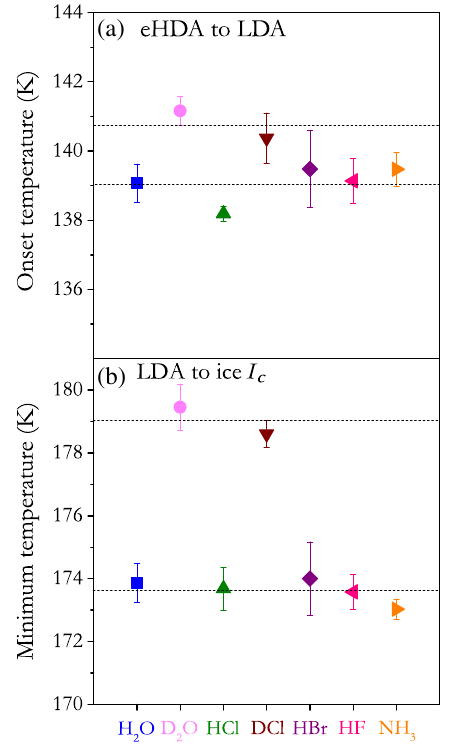
FIG. 4. (a) Onset temperature of the transformation from eHDA to LDA for different isotopes or dopants. (b) Minimum peak temperature for the transition from LDA to ice I FIG. 3. Calorimetric scans obtained for quench-recovered different isotopes or dopants. Black dashed horizontal lines eHDA samples. The samples are heated in the DSC at ambient describe the average values for the H 2 O and/or D 2 O samples. pressure with 50 K min − 1 . Curves are shifted vertically for The error bars reflect the standard deviations obtained from clarity. All curves are shown after subtraction of the second repeated measurements. The colors are consistent with the ones heating scan (this scan on ice I serves as a baseline). The h used in Fig. different colors refer to different dopants or isotopes as indicated.